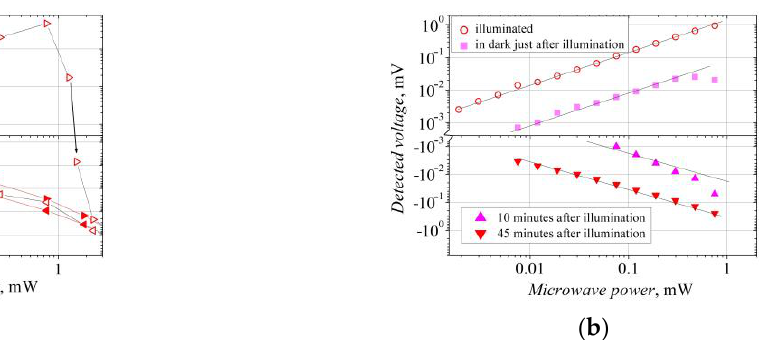
Figure 7. Demonstration of the detection inertness in the W bow-tie diodes: ( a ) influence of microwave power and ( b ) influence of 14,400 lx illumination. Arrows in ( a ) mark the direction of the measurement: fwd, when the microwave power is increased, and bwd, when the power is decreased. The lines in ( b ) are guides representing the linear law.